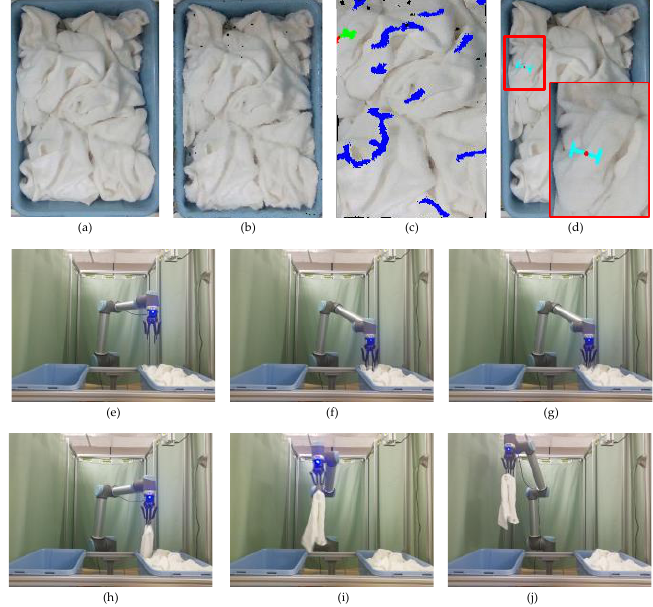
Figure 1. The complete process of the method: ( a ) the RGB image from Realsense D435; ( b ) the point clouds of the white towels; ( c ) the appropriate grasp point on the candidate convex wrinkle; ( d ) the projection of the grasp pose on the image; ( e ) the robotic arm reaches the pre-grasp position; ( f ) the robotic arm reaches the grasp position; ( g ) the robotic arm closes two-finger gripper; ( h ) the robotic arm picks a towel; ( i ) the robotic arm moves the towel from the right laundry basket to the left laundry basket; ( j ) the robotic arm stands by